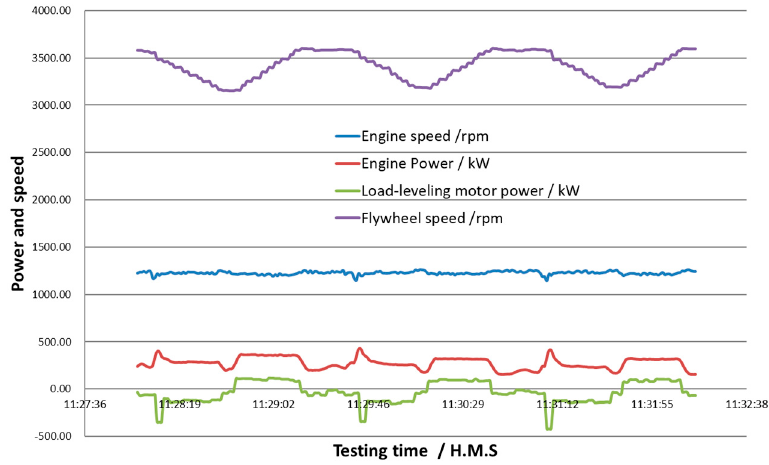
Figure 16. Detailed data in the peak load-leveling running state.